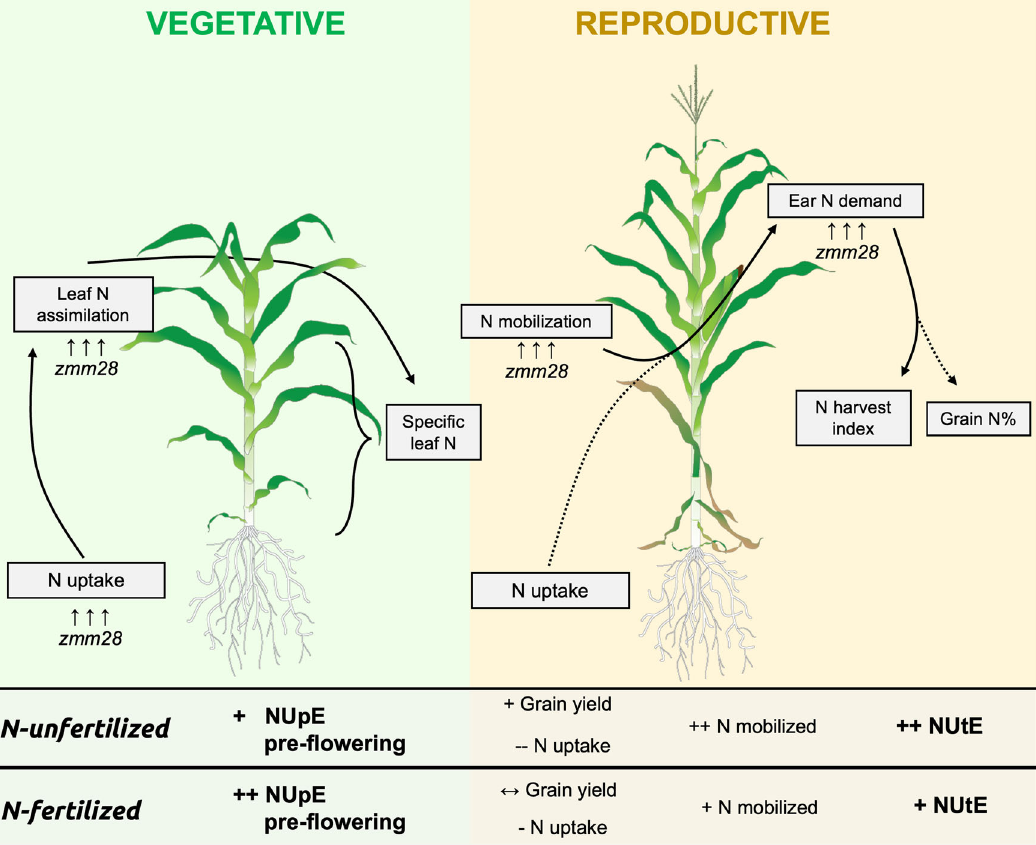
Fig. 4 Physiological model of DP202216 effects on NUE during pre- and post-anthesis. Graphical representation describing the critical impacts of DP202216 ( ZmGos2-zmm28 ) in NUE during pre- and post-anthesis under N-fertilized and N-unfertilized conditions, compared to WT. Plus ( + ) symbols indicate increases, minus ( − ) decreases, and left-right arrows ( ↔ ) no changes observed for one or two hybrids (one/two